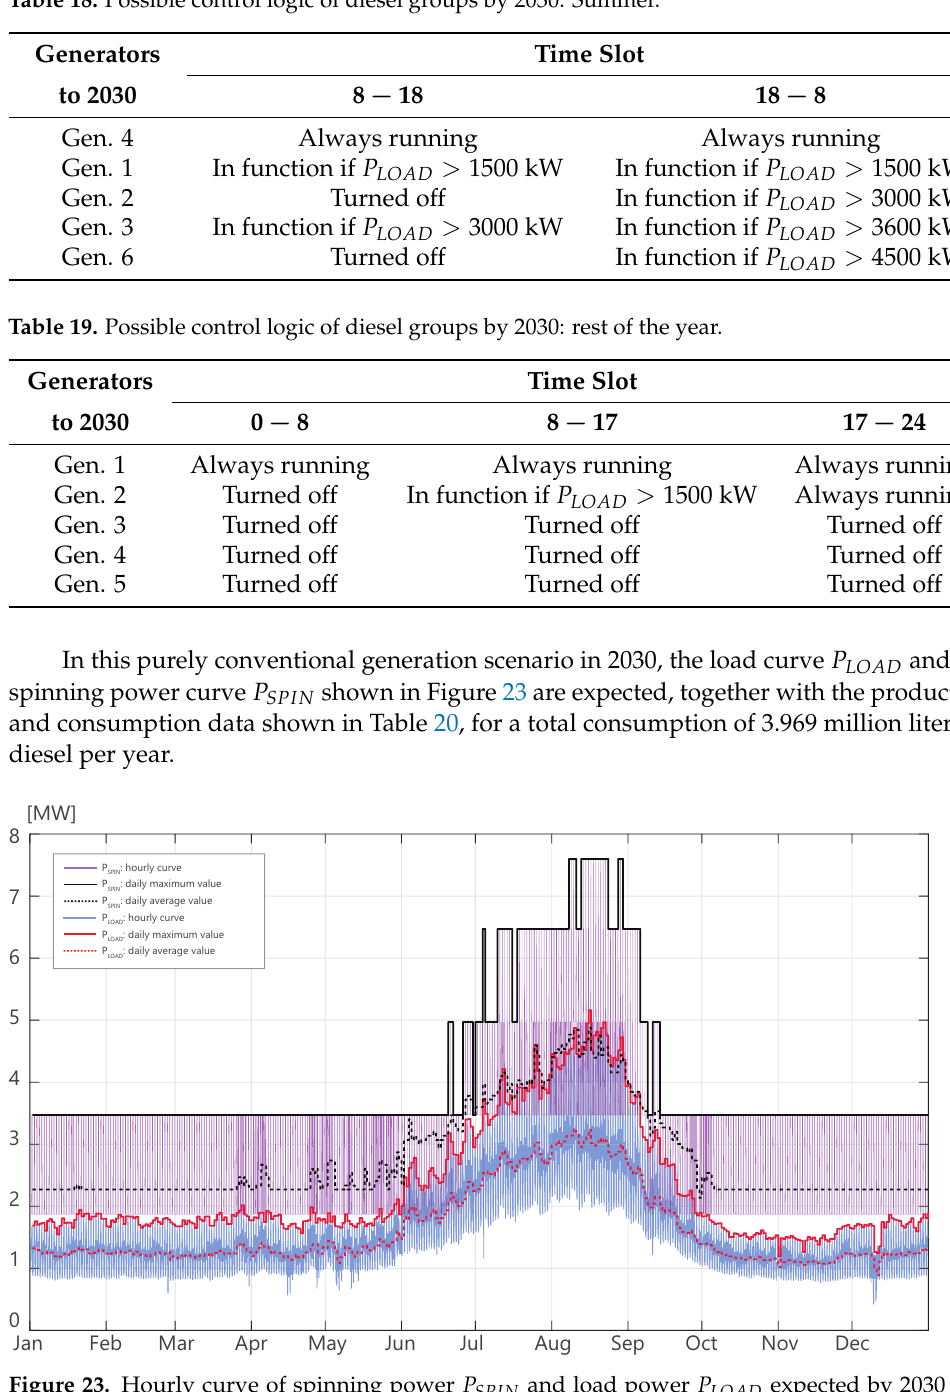
Figure 23. Hourly curve of spinning power P SPIN and load power P LOAD expected by 2030 in a purely conventional generation